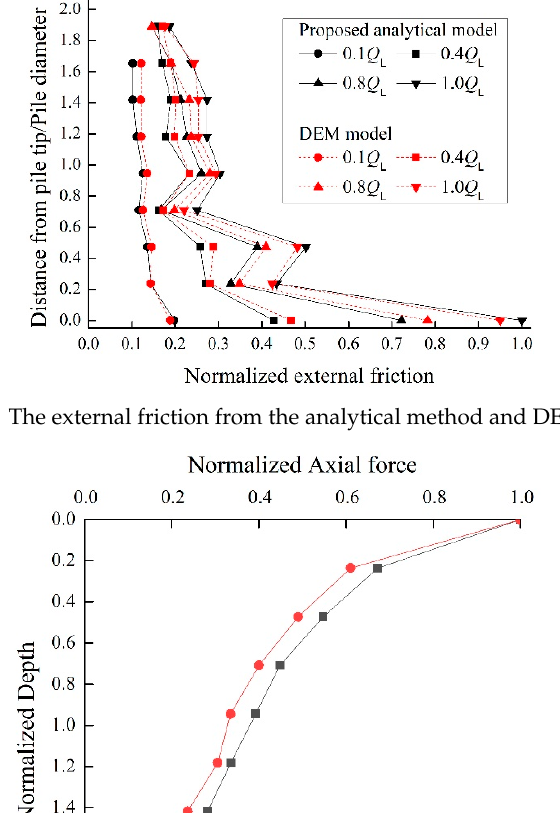
Figure 15. The internal friction from the analytical method and DEM model.